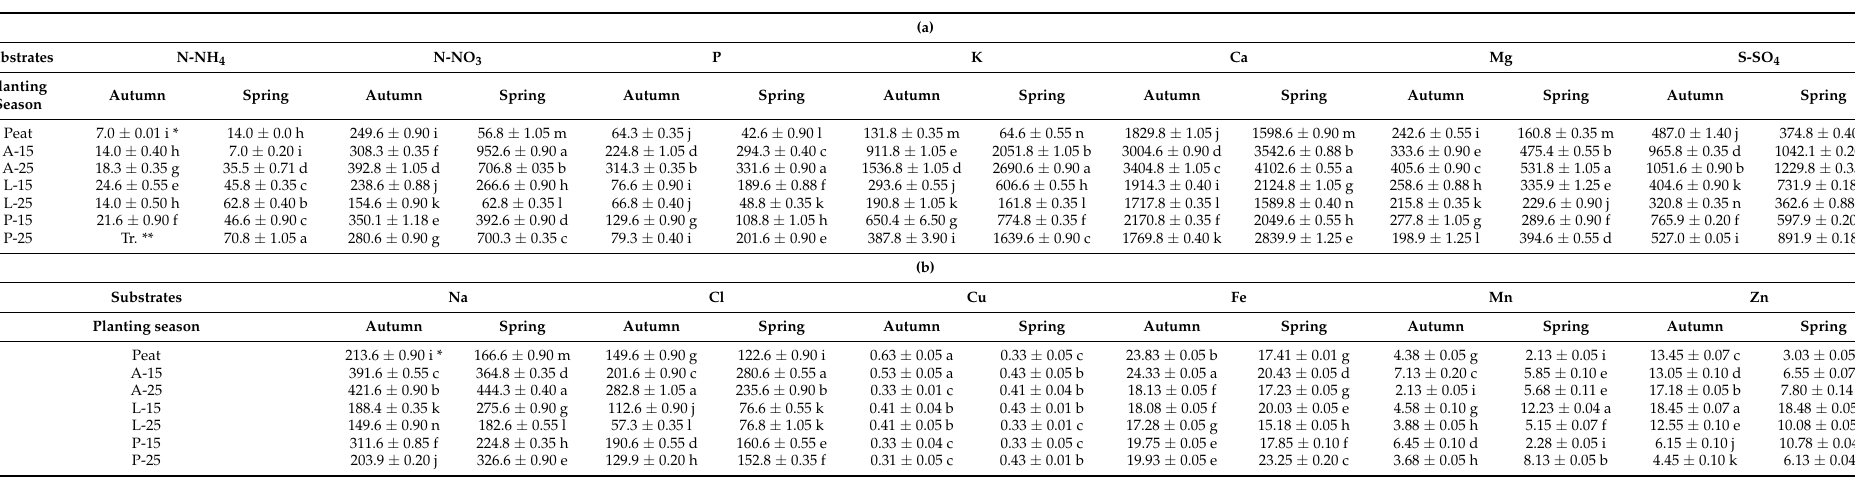
Table 6. ( a ) Macronutrient concentrations in different substrates at the end of strawberry cultivation (mg · dm 3 ). ( b ) Micronutrient concentrations in different substrates at the end of strawberry cultivation (mg · dm 3